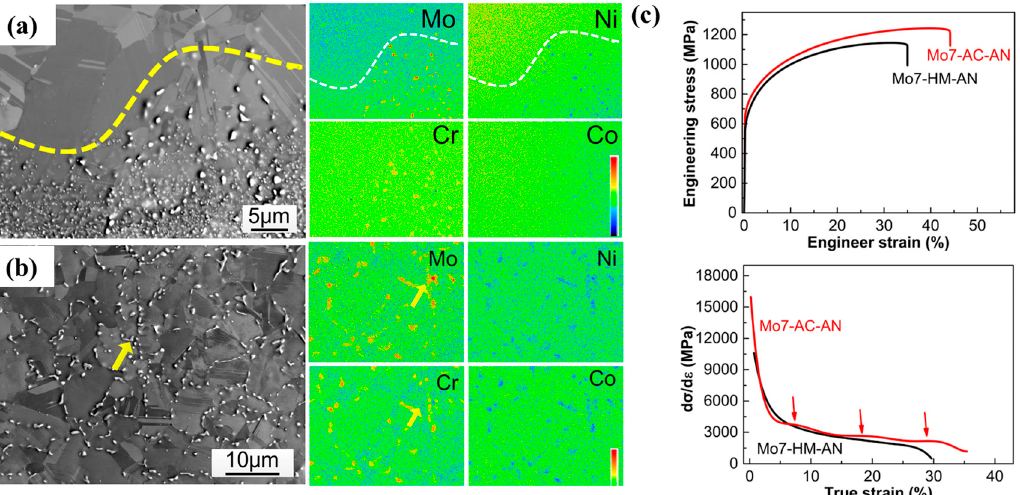
Figure 9. Tensile properties affected by chemical distribution (Reprinted with permission from Ref. [49]. Copyright 2019, Elsevier). ( a ) SEM micrographs and elemental distribution of as–cast (Mo7–AC–AN) and ( b ) homogenized (Mo7–HM–AN) HEAs. ( c ) Engineering stress–strain and work hardening rate curves of the two alloys. The red arrows represent the strain hardening rate platform.